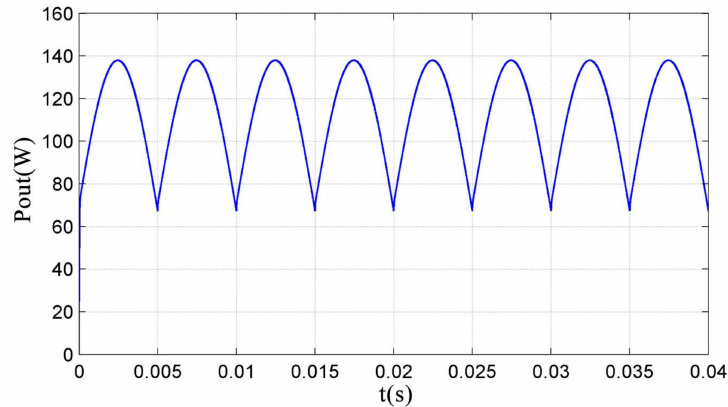
Figure 12. Waveform of the output power against time in the dual-supply system.